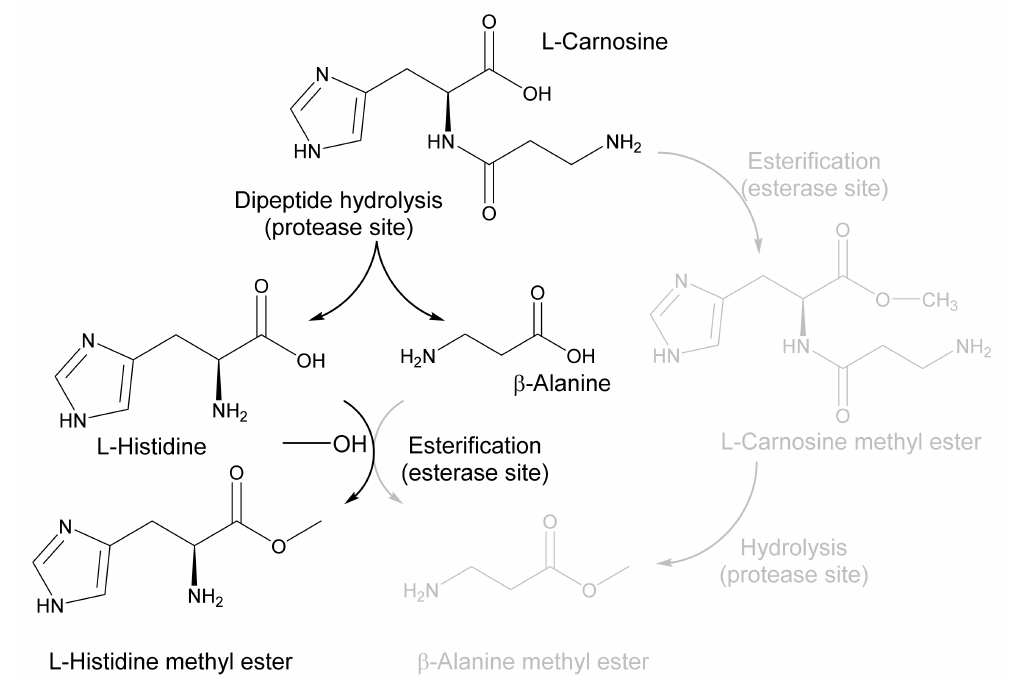
Figure 4. Schematic representation of the main product obtained in a one-pot reaction with the dipeptide L-carnosine ( β -alanine-L-histidine) and methanol. A schematic representation of the two reaction intermediates and the two possible products ( β -alanine and L-histidine methyl esters) is shown. As shown in the figure, the preferential route found is the production of L-histidine methyl ester via the hydrolysis of L-carnosine at the protease site and the selective esterification with methanol of L-histidine (but not β -alanine) at the esterase site. No appreciable formation of L-carnosine methyl ester and β -alanine methyl ester (gray colour) was detected. The figure was created using ChemDraw